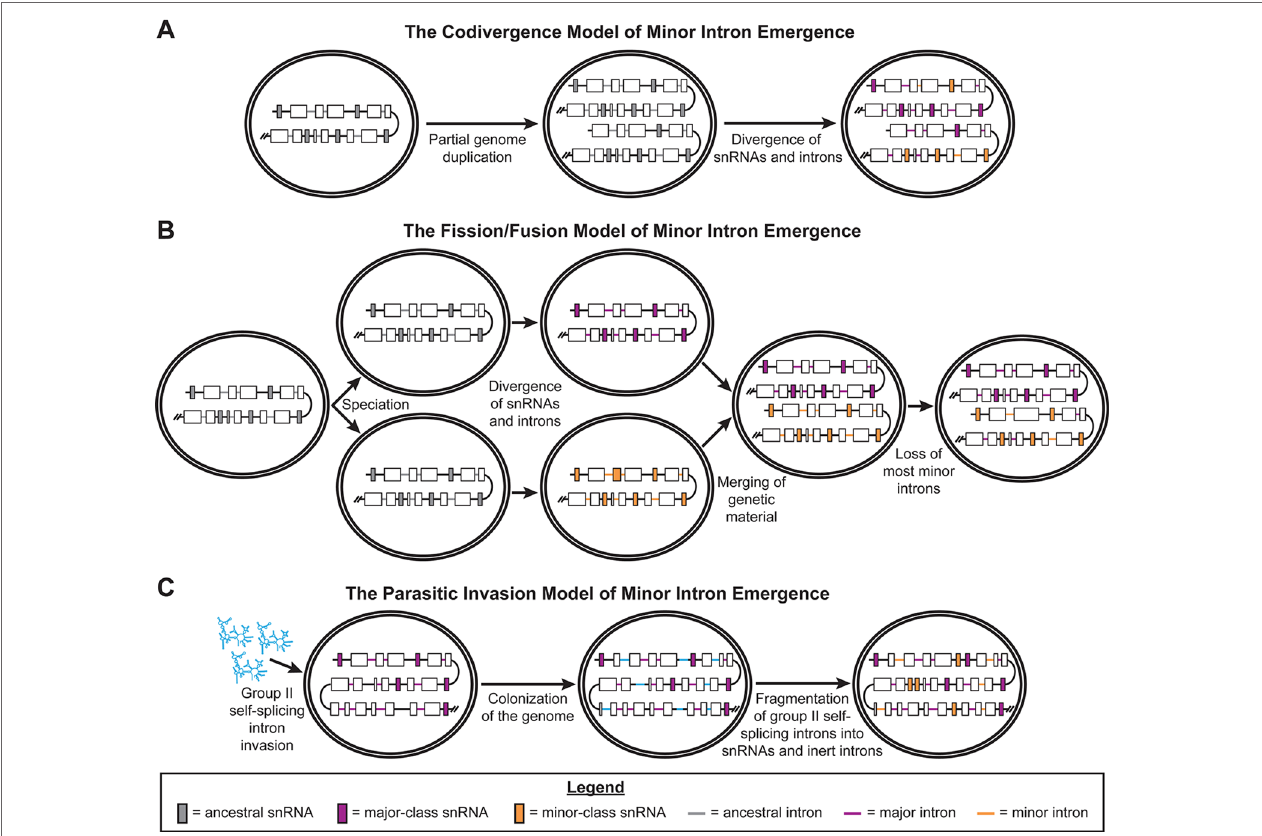
FIGUrE 1 | Previously published models of minor intron emergence. Schematics showing the three models of minor intron emergence proposed by Burge et al. (1998), including (A) the codivergence model, (B) the fission/fusion model, and (C) the parasitic invasion model. Unicellular organisms are shown by the double- bordered ovals, while regions of the genome are displayed as lines. Black lines denote intergenic regions, gray lines for ancestral introns, blue lines for major introns, and purple lines for minor introns. Boxes represent coding regions of genes, with colored boxes denoting ancestral snRNA genes (gray), major spliceosomal snRNA genes (blue), or minor spliceosome-specific snRNA genes (purple). Arrows denote the passage of time; events occurring during this period of time are noted in text under the respective arrow. Reproduced with permission from Burge et al., 1998.